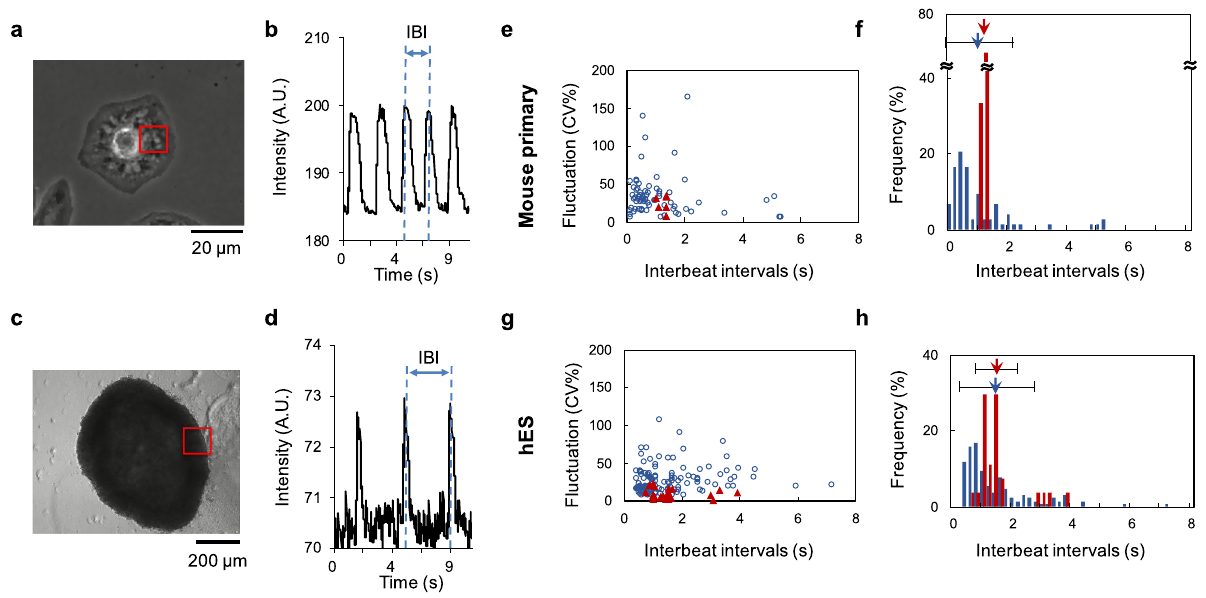
Figure 3. Analysis of interbeat interval (IBI) distribution of single and clustered mouse primary and hES cardiomyocytes. ( a )–( d ): Method of measuring interbeat interval (IBI) of single cardiomyocytes and clusters. Temporal change of luminance in the red square area for single cell ( a ) and cluster ( c ) caused by their beating was recorded, as shown in the time-course intensity profiles ( b ) and ( d ), respectively. IBIs of their beating were acquired from the time intervals between two neighboring peaks in the time-course intensity profiles. ( e ), ( f ): Distribution of IBIs of mouse primary cardiomyocytes. ( e ) The relationship between mean IBIs and fluctuations of beating [coefficient of variability (CV) of IBIs] of single isolated primary cardiomyocytes (blue open circles, n = 73) and primary clusters (red filled triangles, n = 6). ( f ) A histogram of all plots in ( e ). The blue filled bars indicate the frequency of IBIs of single cardiomyocytes; the blue arrow and the error bar indicate the corresponding mean value and standard deviation (SD) of single-cardiomyocyte IBIs, respectively. The red filled bars indicate the frequency of IBIs of clusters; the red arrow and the error bar indicate the corresponding mean value and SD of clusters. ( g ), ( h ): Distribution of IBIs in hES cardiomyocytes. ( g ) The relationship between mean IBIs and CV of IBIs in single isolated hES cardiomyocytes (blue open circles, n = 125) and hES clusters (red filled triangles, n = 27). ( h ) A histogram of all plots in ( g ). The blue filled bars indicate the frequency of IBIs of single cardiomyocytes; the blue arrow and the error bar indicate the corresponding mean values and SD of single cardiomyocytes, respectively. The red filled bars indicate the frequency of IBIs of clusters; the red arrow and the error bar indicate the corresponding mean value and SD of also indicate that the 95% confidence intervals of the median IBI of the constituent single cardiomyocytes were 1.00–1.28 s and 0.844–1.22 s, respectively. As the mean IBIs of their clusters were 1.53 s and 1.54 s, more than 50% of constituent cells in these two clusters also had IBIs that were shorter than these clusters’ IBIs. We also examined the influence of trypsinization on the IBIs of individual cardiomyocytes. We compared the IBIs of the dispersed single cardiomyocytes between before and after trypsinization. First, we measured the IBIs of single cardiomyocytes (n = 50 among 1.0 × 10 3 cells ) 3 days after cultivation in a 35-mm dish; then, we added trypsin-EDTA to the dish and incubated it for 8 min at 37 ◦ C . Next, we rinsed the treated cells, cultivated them again for 3 days in another 35-mm dish, and measured their IBIs (n = 50). Figure 5a shows the distributions of the IBIs and the CV of IBIs in single hES cardiomyocytes before and after trypsinization. The blue open circles indicate the single cardiomyocytes before trypsinization, while the orange open circles indicate them after trypsinization. The distributions of the plots of the two samples showed similar tendencies, with no noticeable difference between them ( p = 0.31 , 95% confidence interval: 0.36 to 0.091), which indicates that the trypsinization did not influence the mean IBIs of single hES cardiomyocytes. For statistical confirmation of this, we re-plotted these results. Figure 5b shows histograms of the IBI distribu- tions of single cardiomyocytes before and after trypsinization. The blue filled bars indicate the frequency of IBIs of single cardiomyocytes before trypsinization; the blue arrow and error bar indicate the corresponding mean value and SD of those cells ( 1.26 ± 0.848 s). The orange filled bars indicate the frequency of IBIs of trypsinized single cardiomyocytes, and the orange arrow and error bar indicate the corresponding mean value and its SD ( 1.30 ± 0.741 s). We also statistically compared these isolated constituent cells with the single hES cardiomyocytes (plotted in Fig. 3g) using the Mann–Whitney U test. The results showed that the p value and 95% confidence interval of each cluster sample were p = 0.56 , 0.12 to 0.24 (Figs. 3g and 4d), p = 0.88 , 0.19 to 0.20 (Figs. 3g and 4e), and p = 0.69 , 0.14 to 0.27 (Figs. 3g and 4f), respectively. These results indicate that there was no significant difference